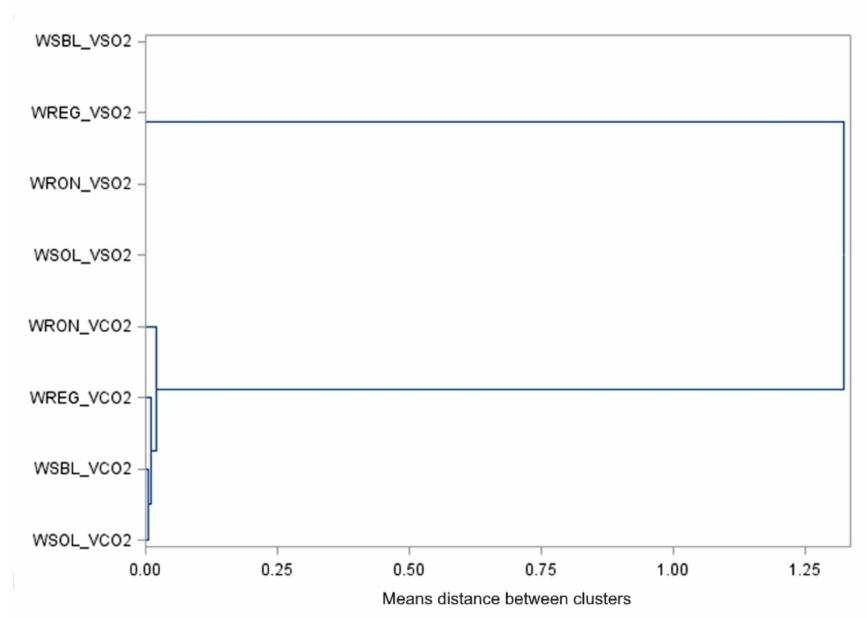
Figure 3. Comparison of analyzed waste shoots of selected grapevine varieties in relation to the balance of substances in the products of grapevine shoot combustion: WSBL—Seyval Blanc, WSOL— Solaris, WREG—Regent, WRON—-Rondo, V CO2 —the carbon dioxide content in the exhaust gas, V SO2 —the content of sulfur dioxide in the exhaust